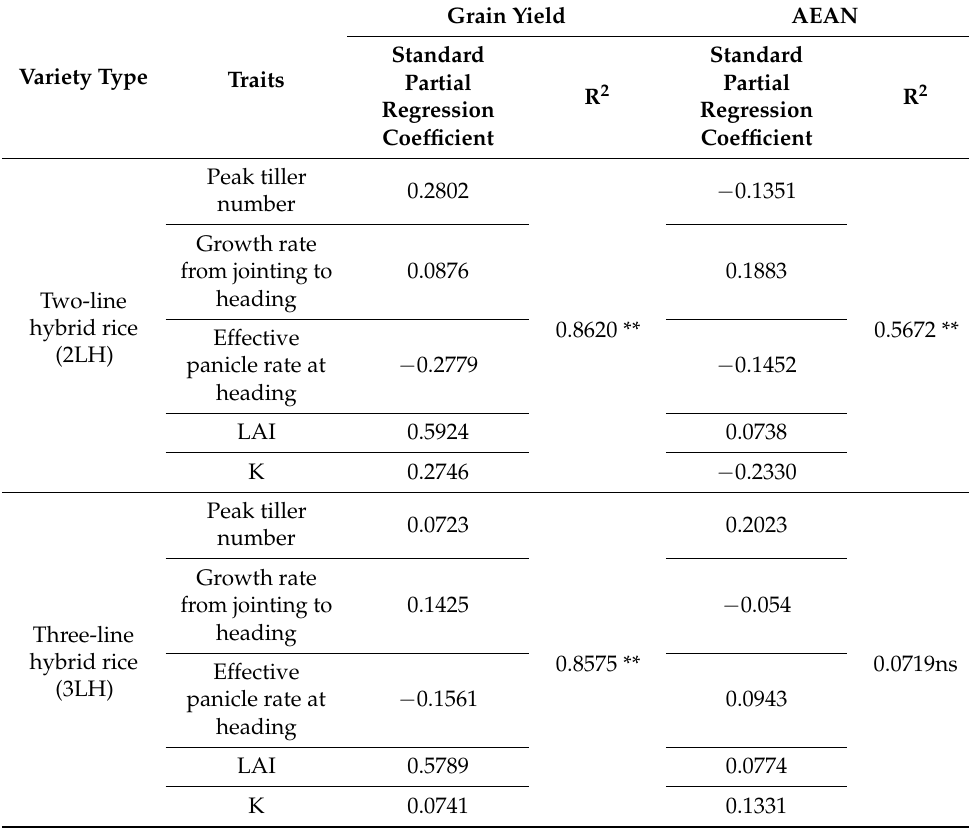
Table 7. Contribution of morphology-related indicators to yield and agronomic efficiency of nitro- gen